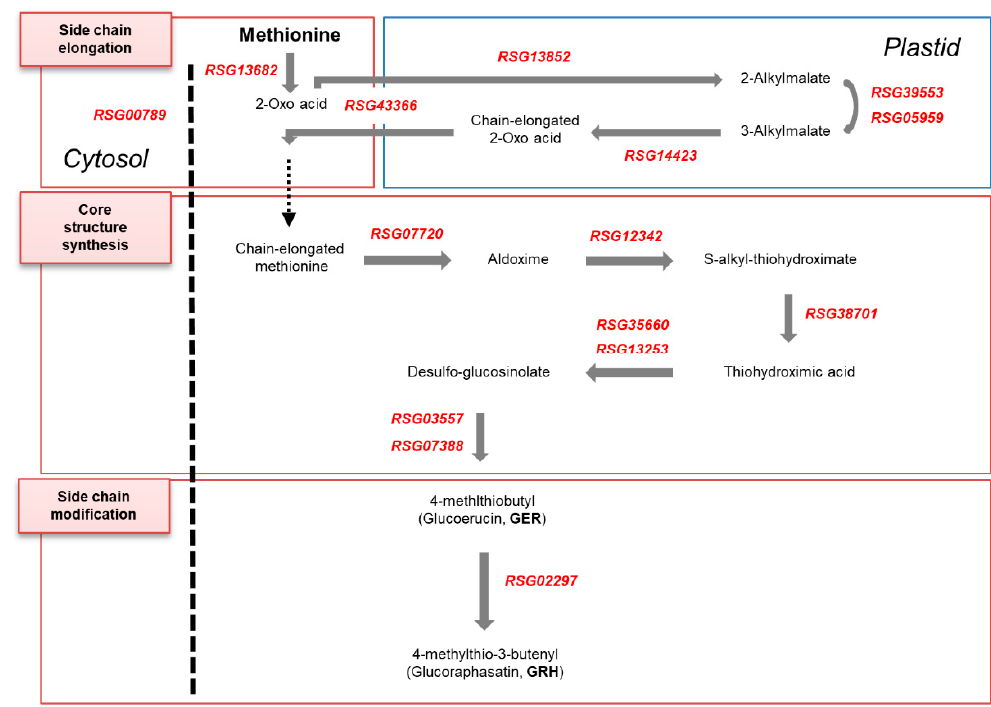
Figure 9. GRH biosynthetic pathway in radish roots. The dotted arrow in the side chain elongation step indicates the putative function of the unknown enzyme.